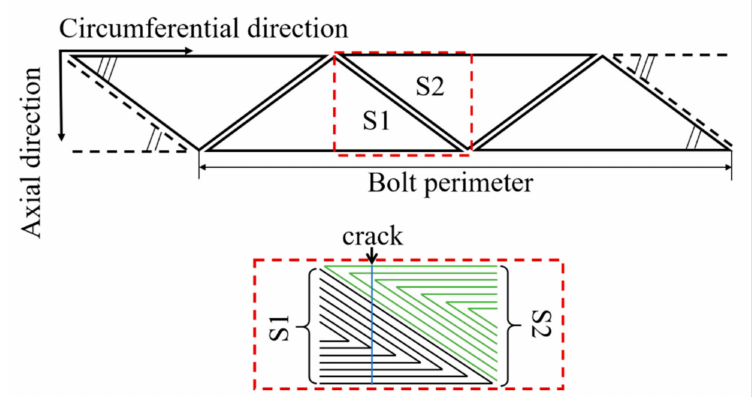
Figure 2. The simplified triangular sensing coil array